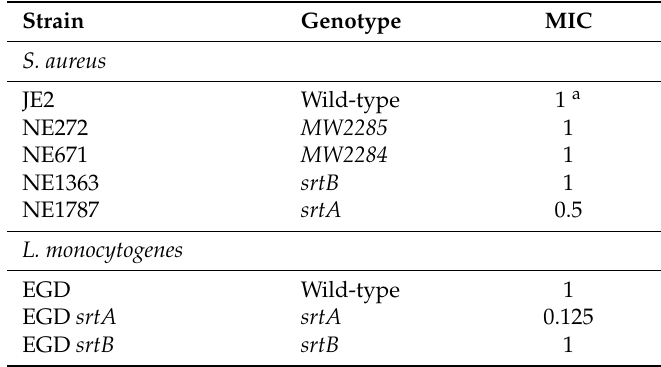
Table 3. MIC results for S. aureus and L. monocytogenes mutants and wild-type strains against SK-03-92.